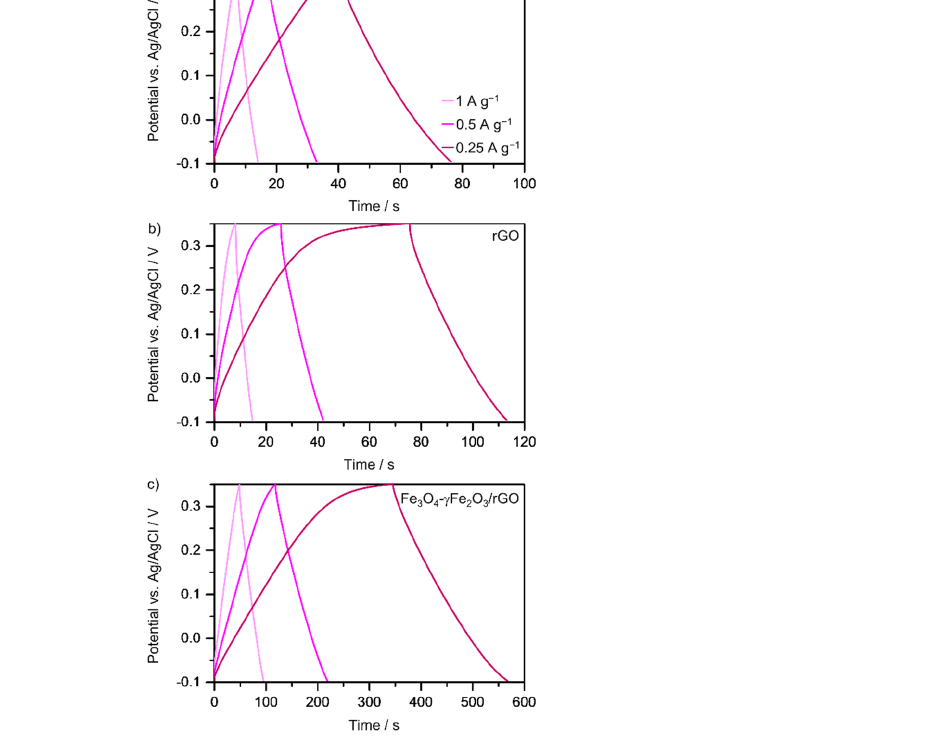
Figure 5. Galvanostatic charge–discharge curves of ( a ) the clusters of Fe 3 O 4 - γ Fe 2 O 3 nanoparticles, ( b ) rGO, and ( c ) the Fe 3 O 4 - γ Fe 2 O 3 /rGO hybrid material at different current densities. Experimental conditions: 3 M KOH solution, room temperature.